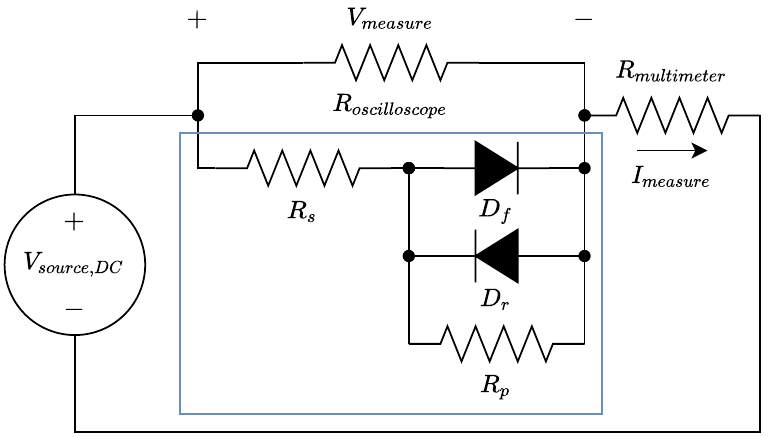
Figure 15. DC measurement